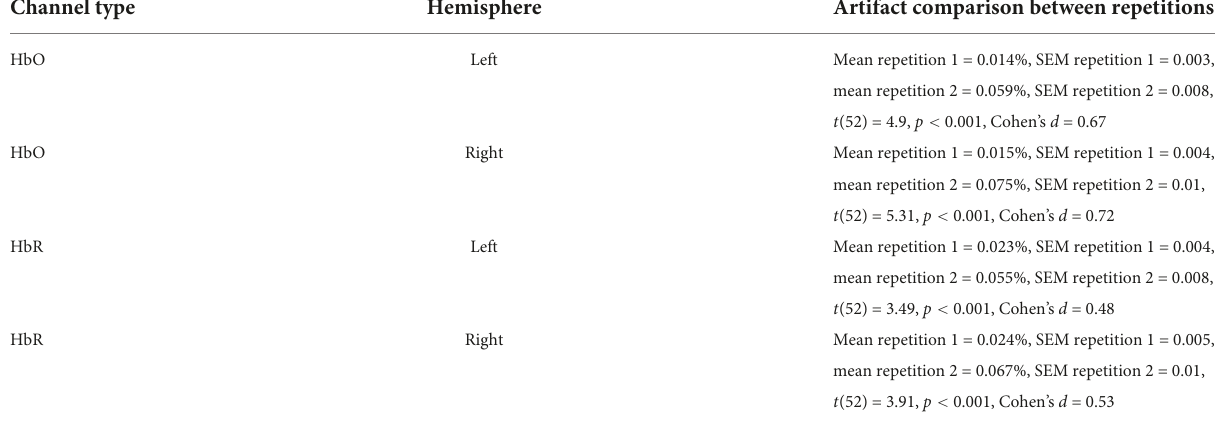
fNIRS activity for the HbO channels (red: fNIRS time-course of movie repetition 1; blue: fNIRS time-course of movie repetition 2). We can already see by visual inspection an